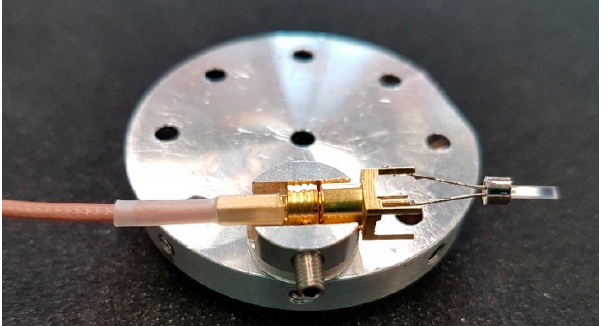
Figure 1. A tuning fork crystal unit with multi-walled carbon nanotubes (MWCNTs) on the tip, soldered to a coaxial straight jack for PCB mounting (SMB) connector and fixed on an aluminum stub. This sample holder configuration was then mounted on the SEM stage.